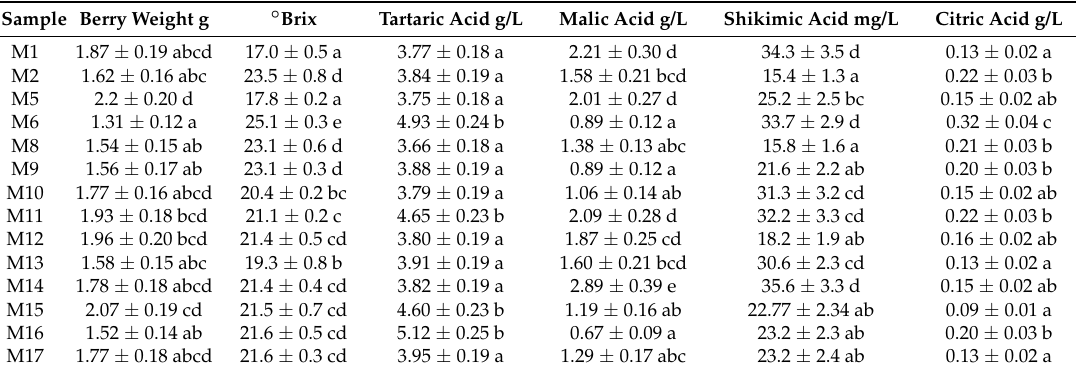
Table 1. Weight, sugars and organic acids composition of berries. Sample Berry Weight g ◦ Brix Tartaric Acid